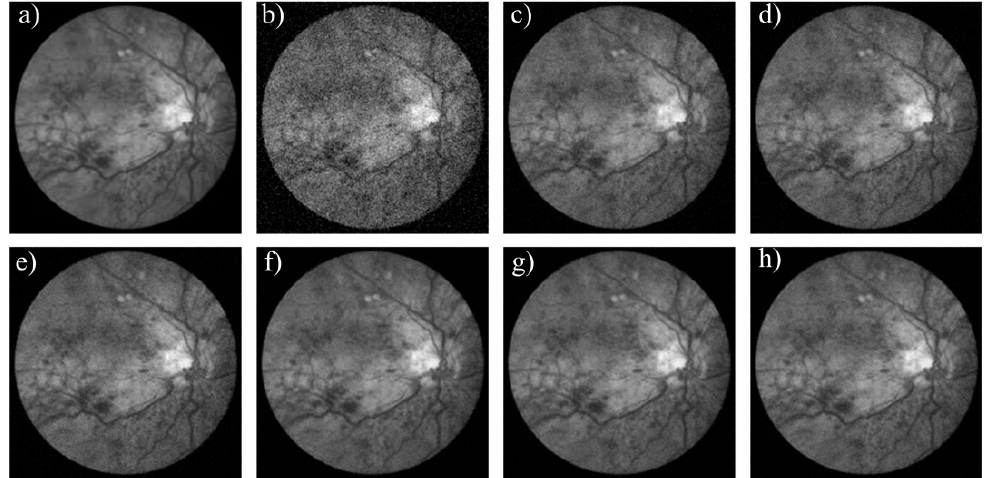
Figure 4. Denoising performance of the six algorithms to the fundus image. ( a ) Original image; ( b ) noisy image; ( c ) MP; ( d ) OMP; ( e ) BP; ( f ) FAL0; ( g ) AL0; ( h ) AL0-L.